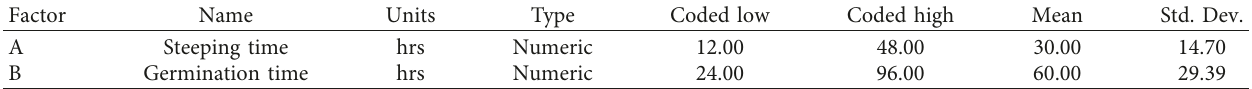
Table 1: Design summary of independent variables (factors) and their actual values.